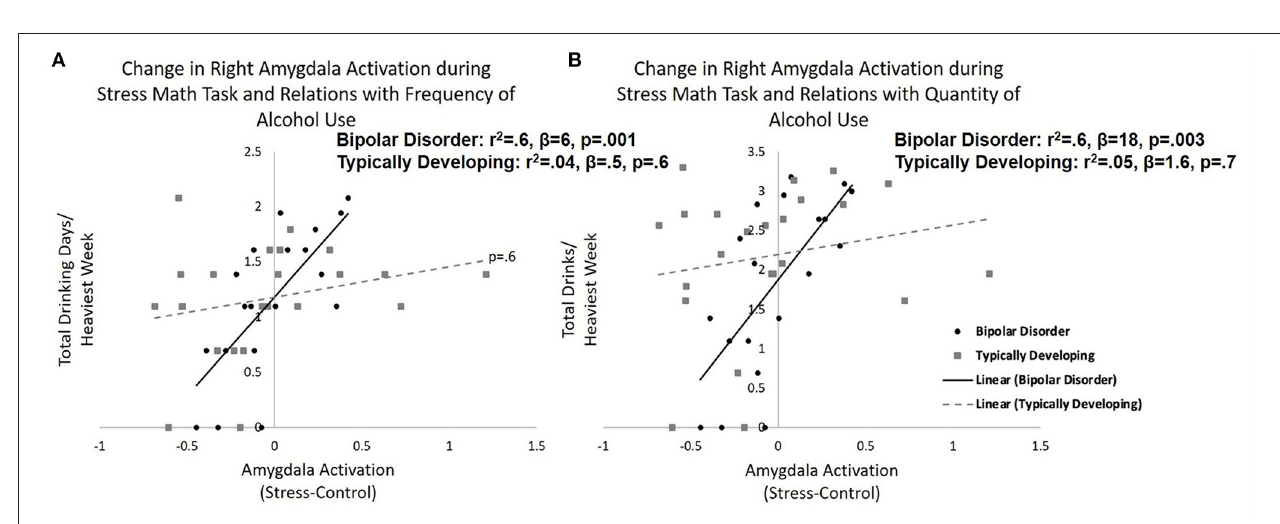
FIGURE 1 | Amygdala reactivity to acute psychosocial stress and associations with recent perceived stress. Relations between recent perceived stress (PSS) and right amygdala reactivity to acute psychosocial stress [stress condition minus control condition during stress math task (SMT)] in typically developing young adults and young adults with bipolar disorder. A group by condition by PSS interaction was observed ( p = 0.02). Greater PSS related to increased right amygdala activation in response to the stress condition, compared to control condition, in bipolar disorder ( p = 0.04), but not in typically developing adolescents/young adults ( p = 0.2).